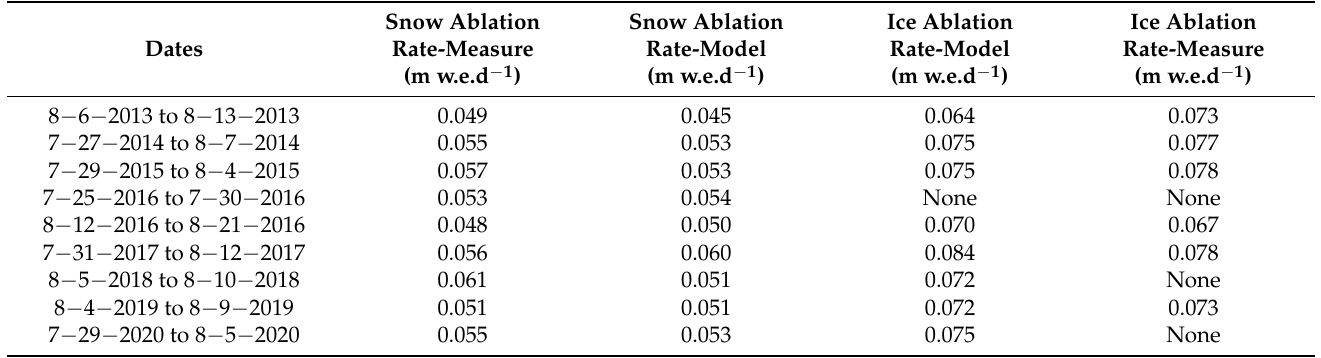
Table 2. Ablation rates determined from field measurements and degree day modeling on Sholes Glacier during portions of the 2012–2020 melt seasons.